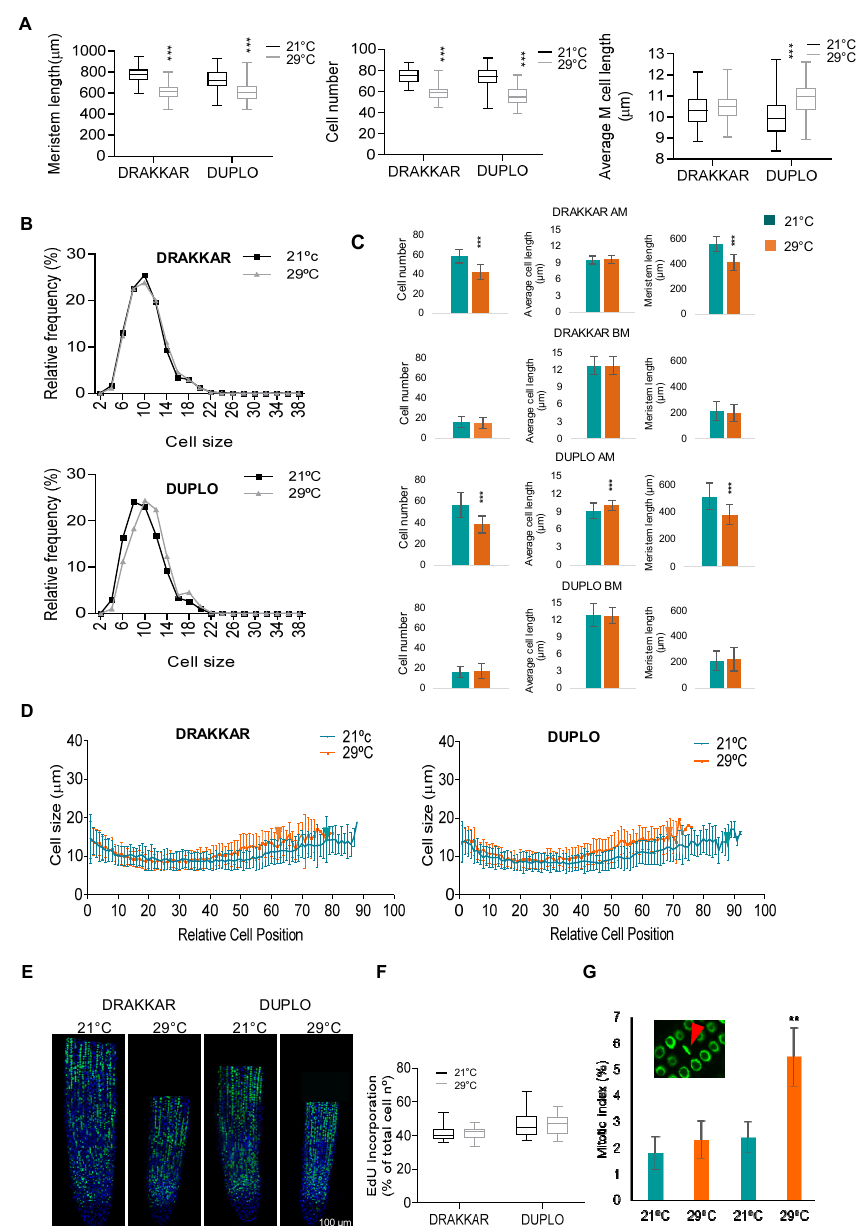
Figure 3. Root meristem changes underlie differential root responses to warm temperatures in B. napus . ( A ) Meristematic cell number, meristem length, and average meristematic cell length of roots of Drakkar and Duplo varieties grown at 21 °C and 29 °C. Both varieties presented shorter root meristems at 29 °C than at 21 °C that correlated to a reduced number of meristematic cells in both genotypes. Statistical t -test analysis, *** FDR < 0.01. ( B ) Distribution of cell size frequencies of meristematic cells in roots of Drakkar and Duplo varieties grown at 21 °C and 29 °C. Warming resulted in a reduction in the number of shorter cells and a consistent increase in the frequencies of longer-sized cells. ( C ) Meristematic cell number, meristem length, and average meristematic cell length of cells in the apical (AM) and basal (BM) meristems of Drakkar and Duplo varieties grown at 21 °C and 29 °C. Statistical t -test analysis, *** p < 0.0001. ( D ) Average cell length of the meristematic cells according to their relative position in the root meristem, from the first cell close to the QC, considered as position 0 in the X -axis, to all the cells up to the last meristematic cell before the elongation zone, of Drakkar and Duplo varieties grown at 21 °C and 29 °C. The boundary between apical and basal meristem starts closer to the QC when roots are grown at warm temperature. Blue and orange